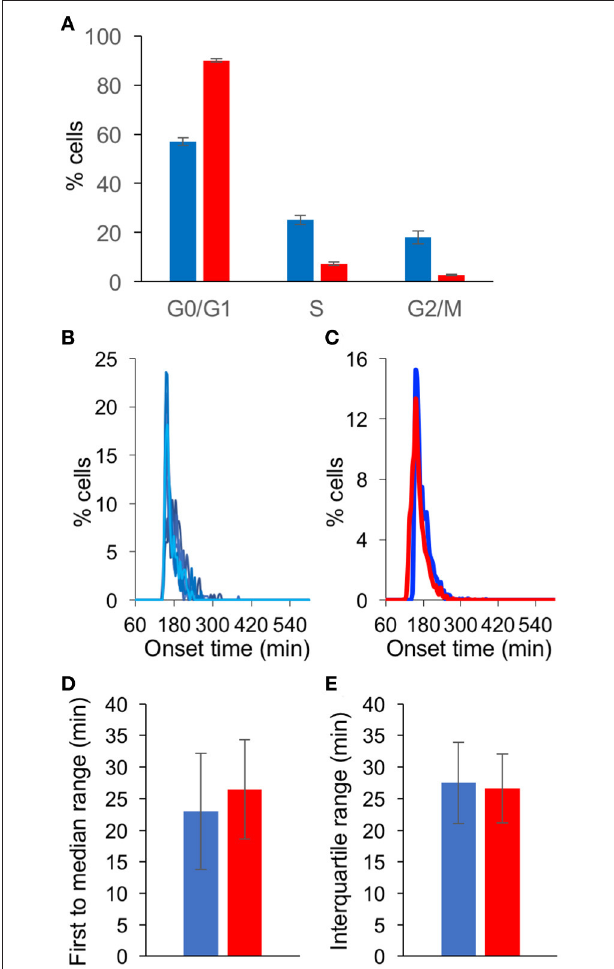
FIGURE 5 | Serum depletion has limited influence of synchronous gene expression. (A) Cells were grown in 10% FBS for 24h (blue) or in 0.5% FBS for 48h (red). The cells were fixed, labeled with propidium iodide and analyzed to determine the cell cycle state in three replicative experiments. The percentage of cells at each cell cycle stage are presented. Error bars represent standard error among three plates (see Supplementary Figure 2 ). (B) Cells grown in 10% FBS were infected with OK11 recombinant virus at 39 ◦ C, at MOI 20. Histograms present the percentage of cells at each time point, that initiated expression (binning every 5min). Eight wells from two experiments done at different days are plotted (four wells per experiment). (C–E) A comparison between the onset times of expression for the infection of cells grown in 10% FBS for 24h (blue, data from (B) and cells grown in 0.5% FBS for 48h (red, data from Figure 4A ). (C) The average histograms for each condition were plotted. (D) The time between the first cell onset of expression to the median cell onset (first to median range) was plotted for each condition. (E) The interquartile range was plotted for each condition. (C–E) Error bars represent the standard deviation among the different